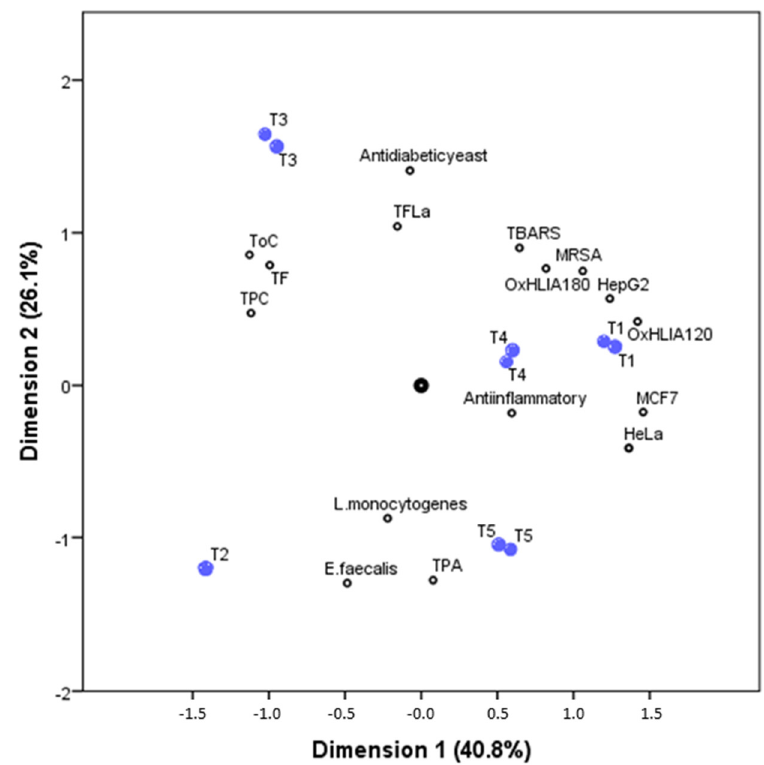
Figure 1. Biplot of object scores (plant tisanes, blue dots) and component loadings (families of phe- nolic compounds and some bioactive properties, black dots) from CATPCA. The first two dimen- sions (first: Cronbach's α , 0.917; eigenvalue, 7.308; second: Cronbach's α , 0.864; eigenvalue, 5.359) account for most of the